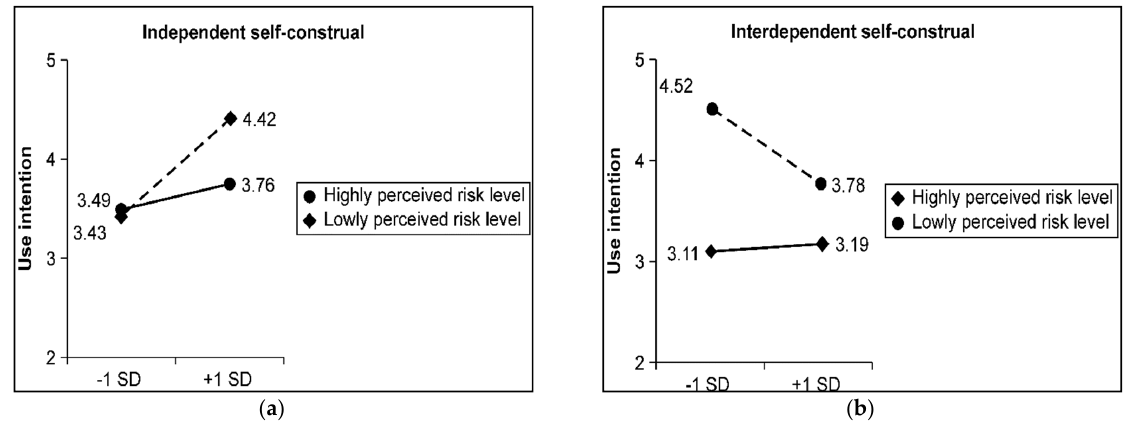
Figure 2. Use intention: ( a ) use intention toward the mobile app as a function of participants’ independent self-construal and perceived risk; ( b ) use intention toward the mobile app as a function of participants’ interdependent self-construal and perceived risk; SD is standard deviation.